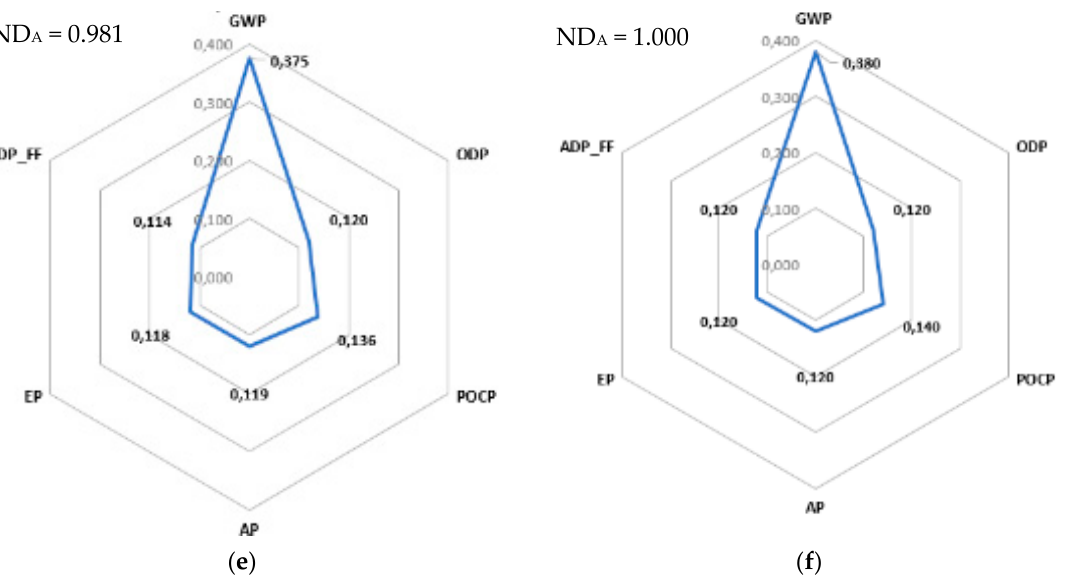
Figure 17. Sustainability profiles and environmental performance values of each form layout and respective overall environmental performance (ND A ). Legend: ( a ) PA; ( b ) HA; ( c ) SHA90° 19/15; ( d ) SHA90° 38/30; ( e ) DHA90° 25/20; ( f ) DHA90° 50/40.